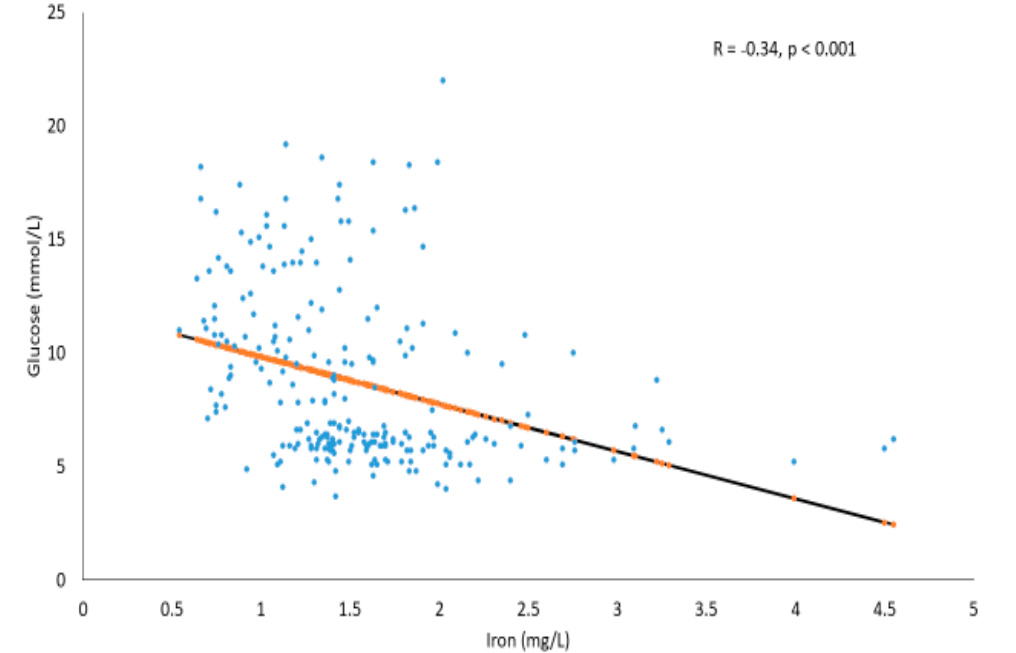
Figure 2. Correlation between glucose (mmol/L) and Fe (mg/L) in T2DM and prediabetes subjects.